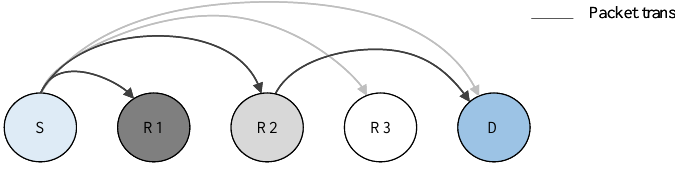
Figure 3. Uncertainty of wireless